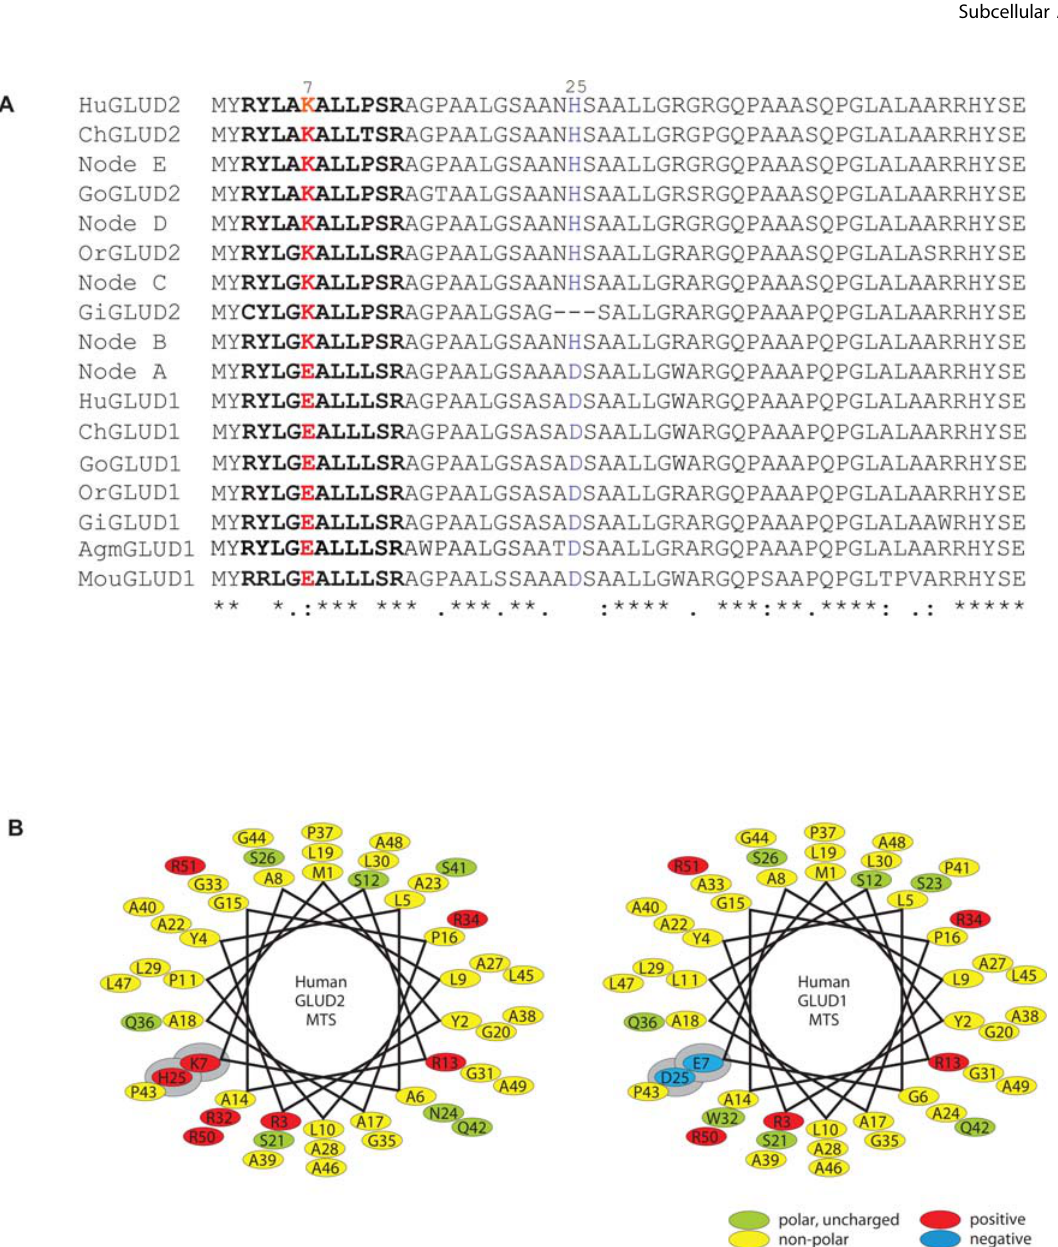
Figure 2. Sequences and Structures of the GLUD Mitochondrial Targeting Sequences. (A) Alignment of GLUD MTSs (same abbreviations as in Figure 1). Sites under positive selection are highlighted in bold red (residue 7) or blue (residue 25). We note that the substitutions A24N and D25H could not be unambiguously assigned to the branch node A–B and branch node B–C due to the deletion at these positions in gibbon (see also legend of Figure 1). The sequences shown were reconstructed assuming that these substitutions occurred on branch A–B. (B) Schematic representation of the MTSs of GLUD1 and GLUD2 from humans. Amino acids 1 to 51 were plotted onto a helical wheel representing an a-helix (3.6 residues per turn) viewed from the top. Polar uncharged (green), non-polar (yellow), positive (red), and negative (blue) residues are indicated. Residues predicted to be particularly important for mitochondrial targeting are highlighted in grey.